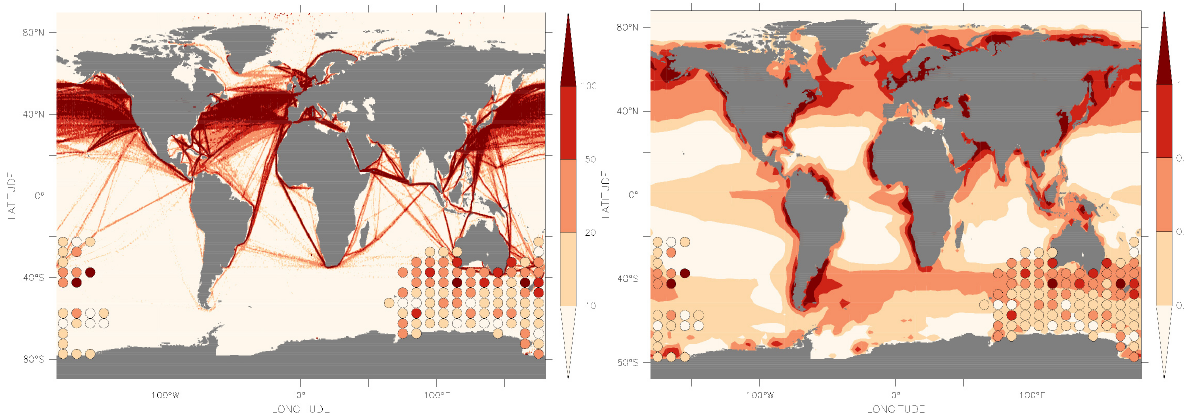
Fig. 2. Geographic distribution of IN concentrations observed by B73, compared to ship emissions and chlorophyll. Top: natural logarithm of estimated particulates emitted from ships, assuming an 800-m boundary layer height and 5-day residence time in the boundary layer (µgm − 3 ), calculated from estimated year 1970 emissions (Endresen et al., 2003; Eyring et al., 2005, 2010; Wang et al., 2007; Lamarque et al. , 2010), with the natural logarithm of B73 IN mean number density (m − 3 ) superimposed as coloured dots (different colour scale). Bottom: mean ocean chlorophyll a concentrations from MODIS-Aqua (mgm − 3 , July 2002–June 2008), with IN number densities (IN active at − 15 ◦ C per m 3 , × 10) observed by